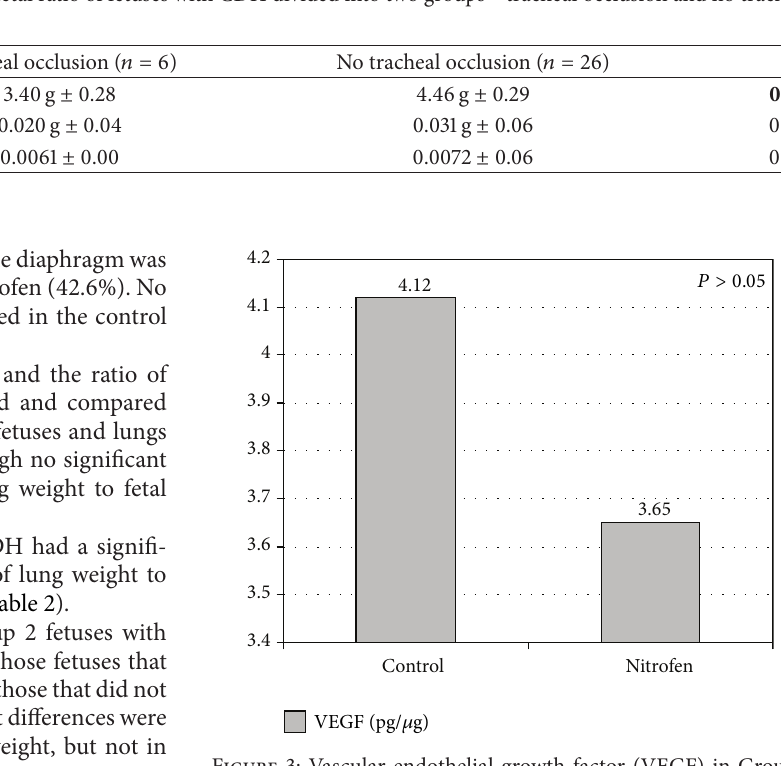
Figure 3: Vascular endothelial growth factor (VEGF) in Group 1 (controls) versus Group 2 (nitrofen). Values are expressed as mean (pg/ 𝜇